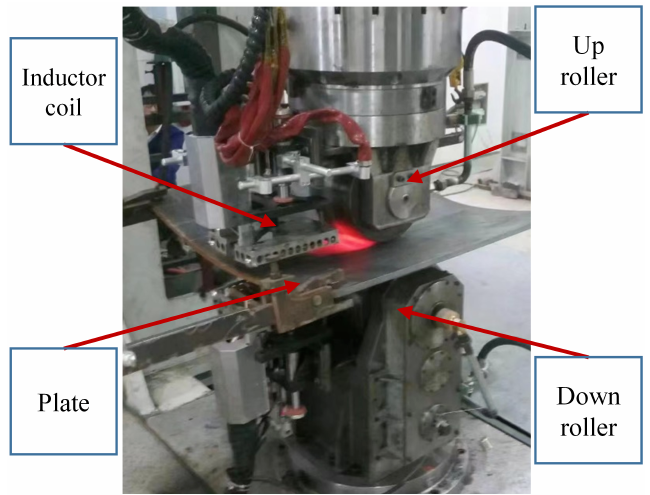
Figure 18. Experimental platform.